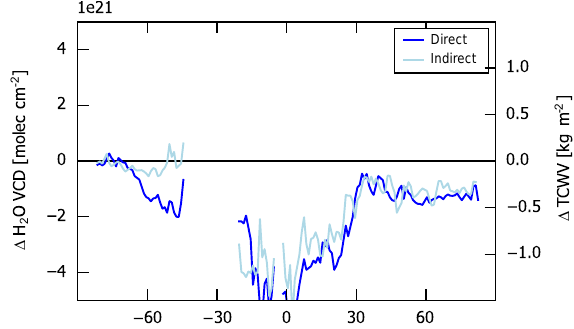
Figure 8. Zonal mean of direct and indirect TCWV differences be- tween GOME-2 and GOME over ocean as a function of